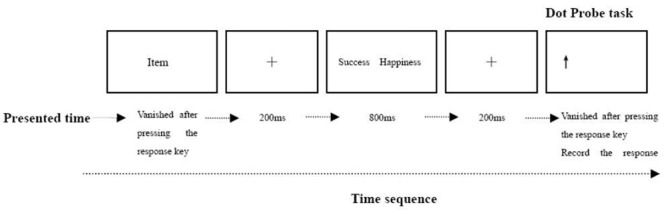
Time sequence of implicit experiment on a given trial. The display depicts the time sequence of a test session trial, which consisted of priming sentence, cross-fixed, two category words, cross-fixed and target probe. The actual stimuli were white against a black background.